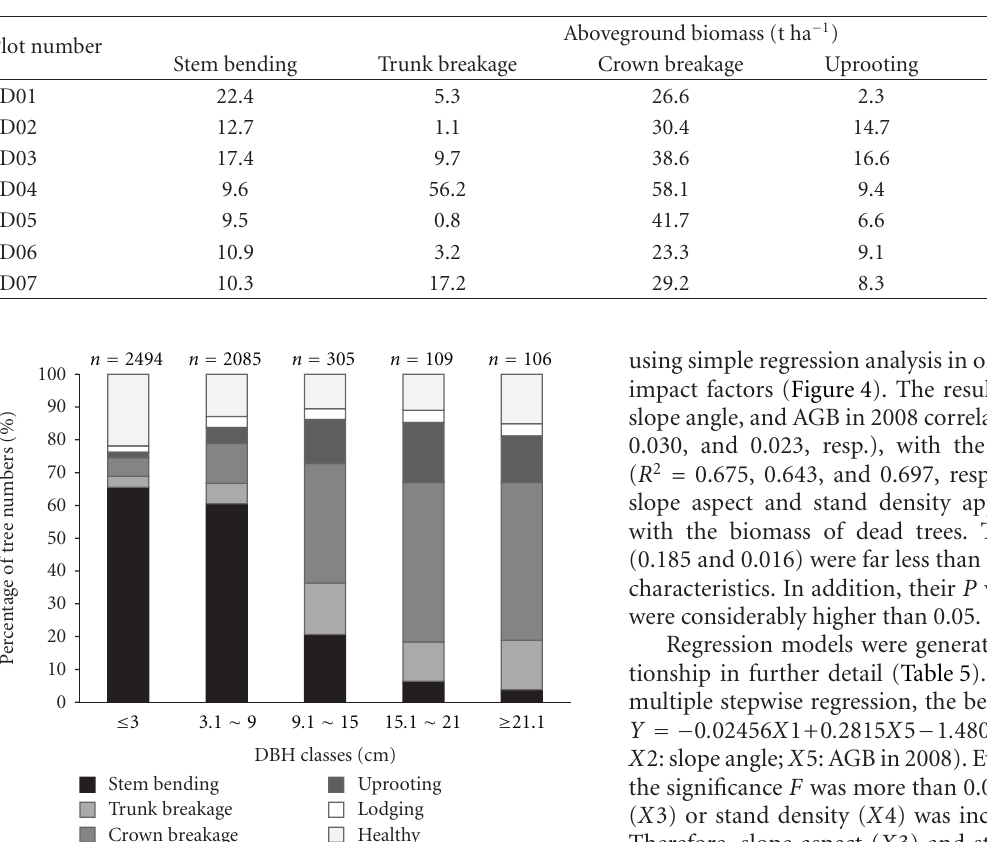
Figure 3: Distribution of trees and types of damage for di ff erent DBH